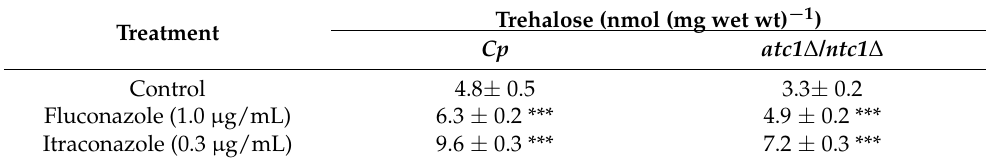
Table 2. Effect of ITC and FLC on the trehalose content on FLC- and ITC-treated cells of C. parapsilosis . YPD-growing exponential yeast cells (OD 600 = − 0.8–1.0) of the two studied strains were exposed at 37 ◦ C for 1 h with the indicated concentrations of FLC or ITC. Trehalose content was measured as described in Methods. The data represent the mean ± SD of three independent determinations. Statistically significant differences (*** = p < 0.001) were recorded with respect to an untreated control according to the Mann–Whitney U